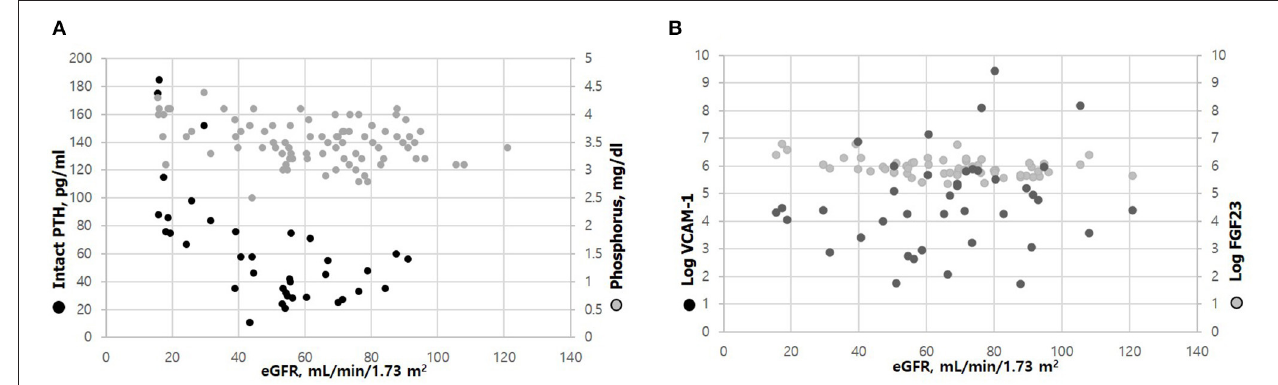
FIGURE 1 | Scatter plot of the relationships between eGFR and iPTH; phosphorus (A) , and Log FGF23; Log VCAM-1 (B) . Phosphorus, iPTH, and Log VACM-1 were correlated with eGFR significantly ( r = − 0.32. p = 0.003 for phosphorus; r = − 0.631, p < 0.001 for PTH; r = − 0.405, p < 0.001 for Log VACM-1. There was no significant trend of Log FGF 23 in relation to eGFR (B) .